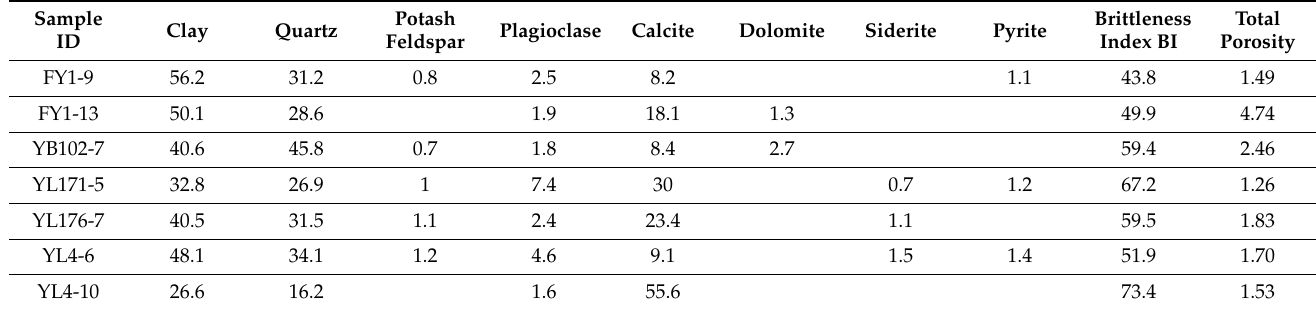
Table 1. Brief table of brittleness index calculation results of the sample.